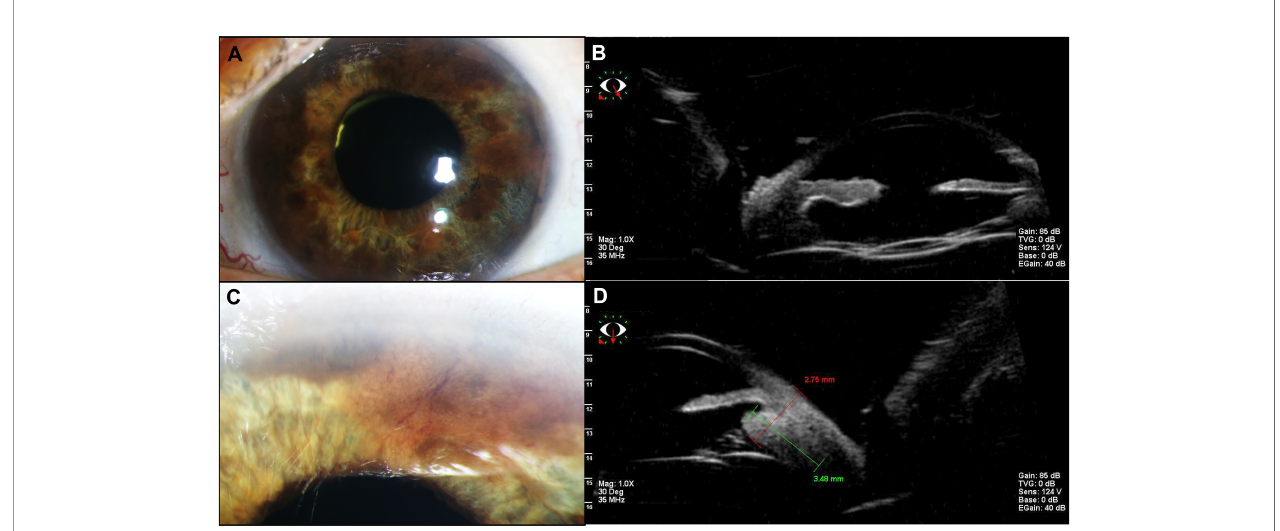
FIGURE 2 | Presentation of the recurrence. (A) The slit-lamp examination of the anterior segment shows an episcleral sentinel vessel and vascularized, melanotic lesions in fi ltrating the iris circumferentially. (B) Close-up image focusing on the iridial lesions with vascularization. (C) The ultrasound biomicroscopy (UBM) of the temporal – inferior iridociliary junction illustrates the thickening of the iris. (D) The UBM of the inferior – anterior segment reveals ciliary body in fi ltration, measuring 2.75 × 3.84 mm at this site. With UBM, iridial and ciliary body thickening was unveiled